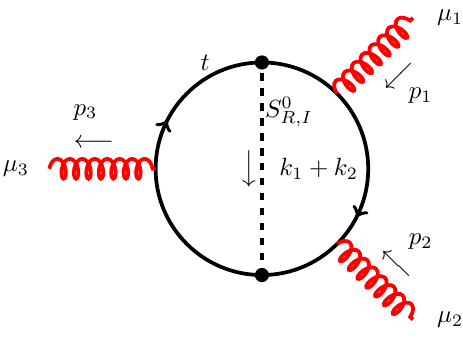
Figure 12 . Diagram contributing to the Weinberg operator proportional to the loop function h ( r ) . The momentum directions are shown to facilitate the reproducibility of our